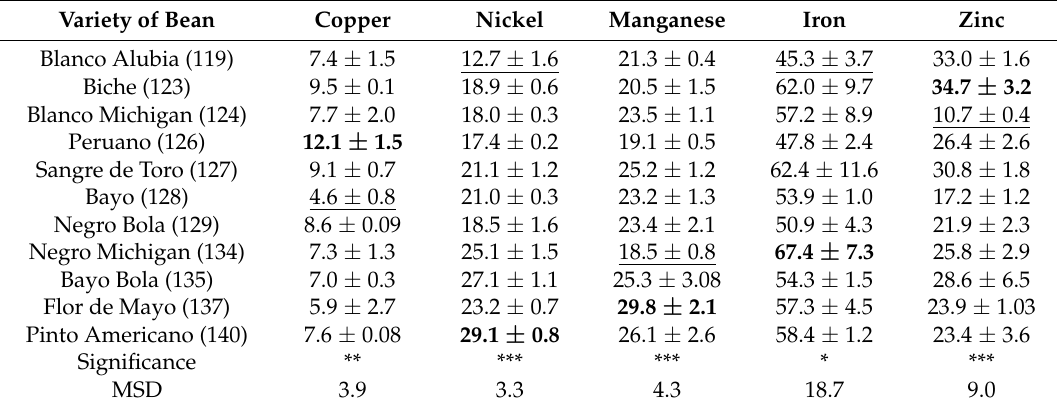
Table 5. Micronutrients concentrations (ppm) in bean varieties produced and consumed in the State of Oaxaca,